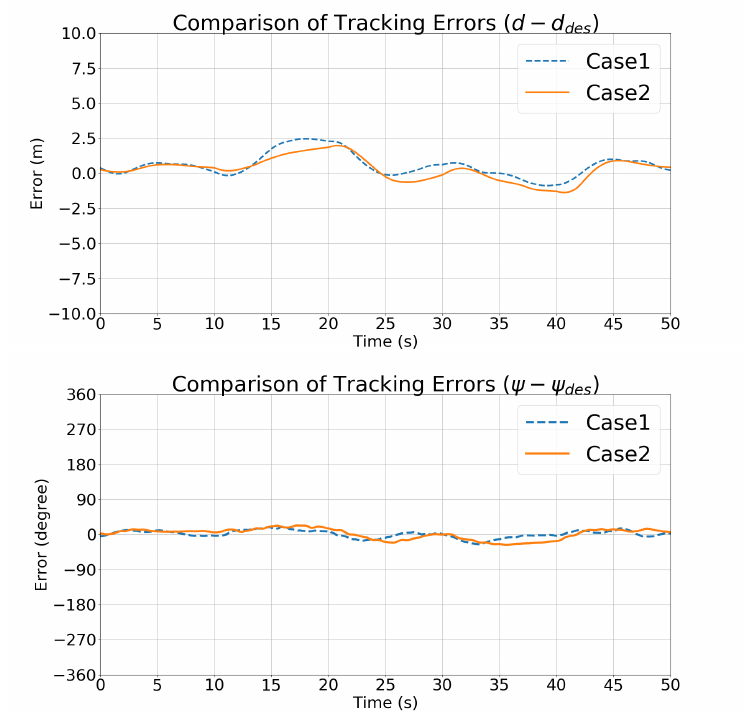
Figure 17. Simulation 2: comparisons of the state vector tracking errors.